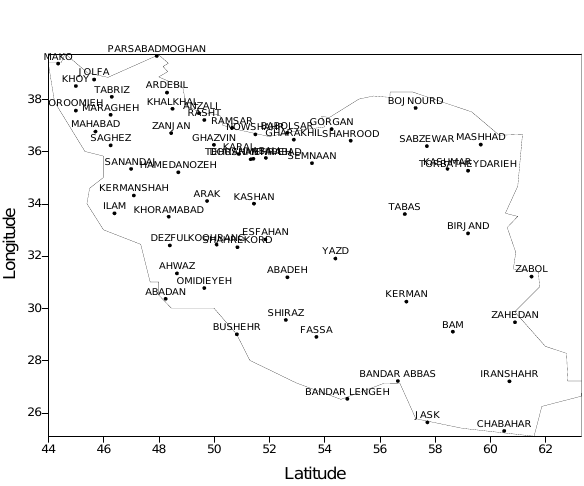
Ratio of extreme rains from the annual rain Thanks for your quick response. The correspondence is B. Alijani and so B is correct. The Figure 1 should have 4 border lines as the following map. Pleas replace it with the following map.